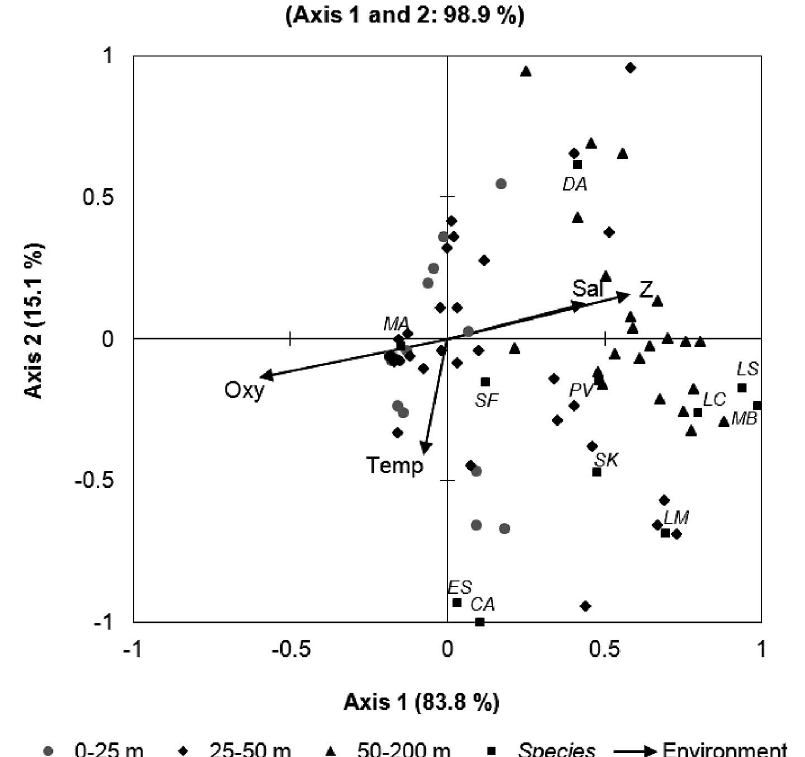
Fig. 5. – Canonical correspondence analysis triplot based on data from spring 2008 showing scores of sampling sites by depth strata, the 11 most abundant siphonophore species and oceanographic variables. MA, Muggiaea atlantica ; LC, Lensia conoidea ; DA, Dimophyes arctica ; PV, Pyrostephos vanhoeffeni ; LM, Lensia meteori ; SK, Sphaeronectes koellikeri ; SF, Sphaeronectes fragilis ; LS, Lensia subtilis ; ES, Eudox- oides spiralis ; MB, Muggiaea bargmannae ; CA, Chelophyes appendiculata ; Z, depth strata; Temp, temperature; Sal, salinity; Oxy, dissolved